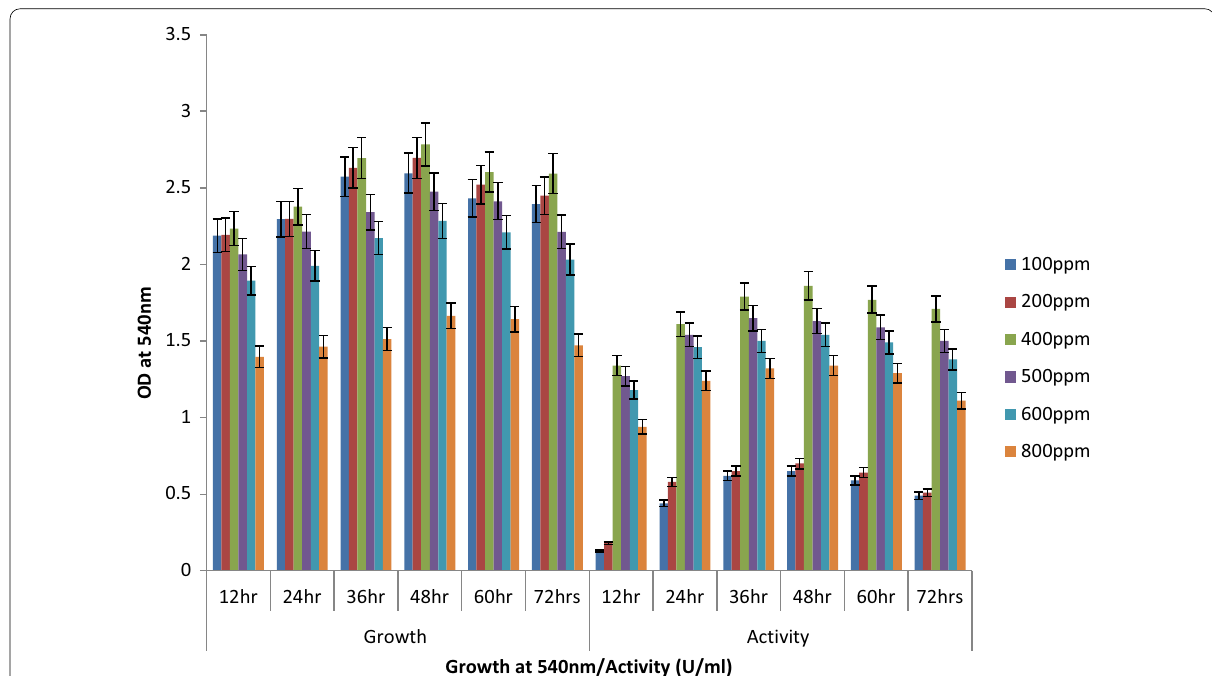
Fig. 7 Effect of substrate concentration on growth and linamarase activity of L. fermentum